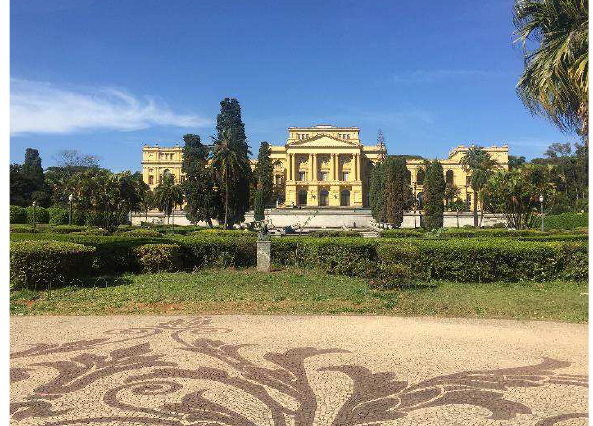
Figure 2. View of the perspective axis in the direction of the Monumento à Independência from the roof of the Museu do